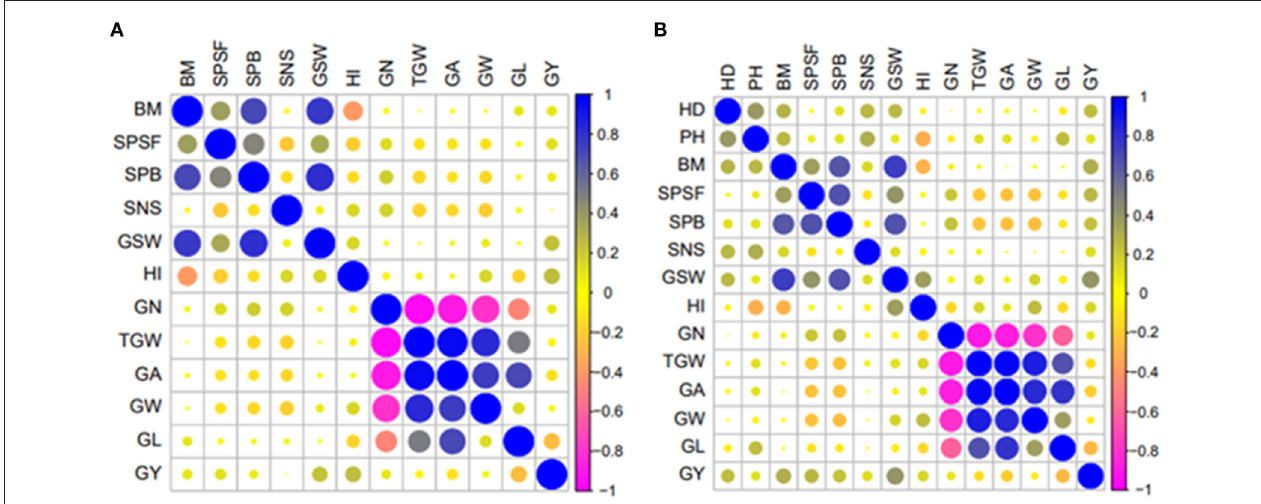
FIGURE 2 | Pearson’s correlation coefficients between yield and yield component traits at Colby in 2018 rainfed trial (A) and Ashland in 2020 rainfed trial (B) . Where HD, heading date; PH, plant height; BM, aboveground dry biomass; SPSF, spikes per square foot; SPB, spikes per bag; SNS, spikelet number per spike; GSW, grain sample weight; HI, harvest index; GN, grain number; TGW, 1,000 grain weight; GA, grain area; GW, grain width; GL, grain length; GY, grain